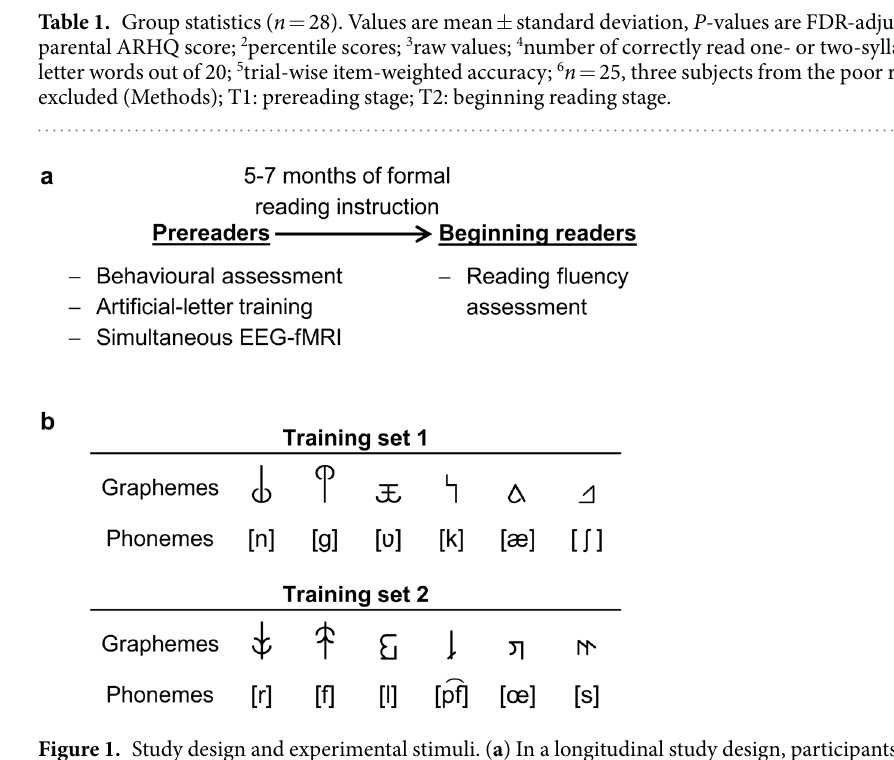
Adding the learning rate from the artificial-letter training ( P = 0.0239) to the model improved the overall cross-validated predictive accuracy to 67.9%, meaning that two additional subjects were correctly classified. While this model identified normal readers with higher specificity -80%- its sensitivity of 53.9% in identifying